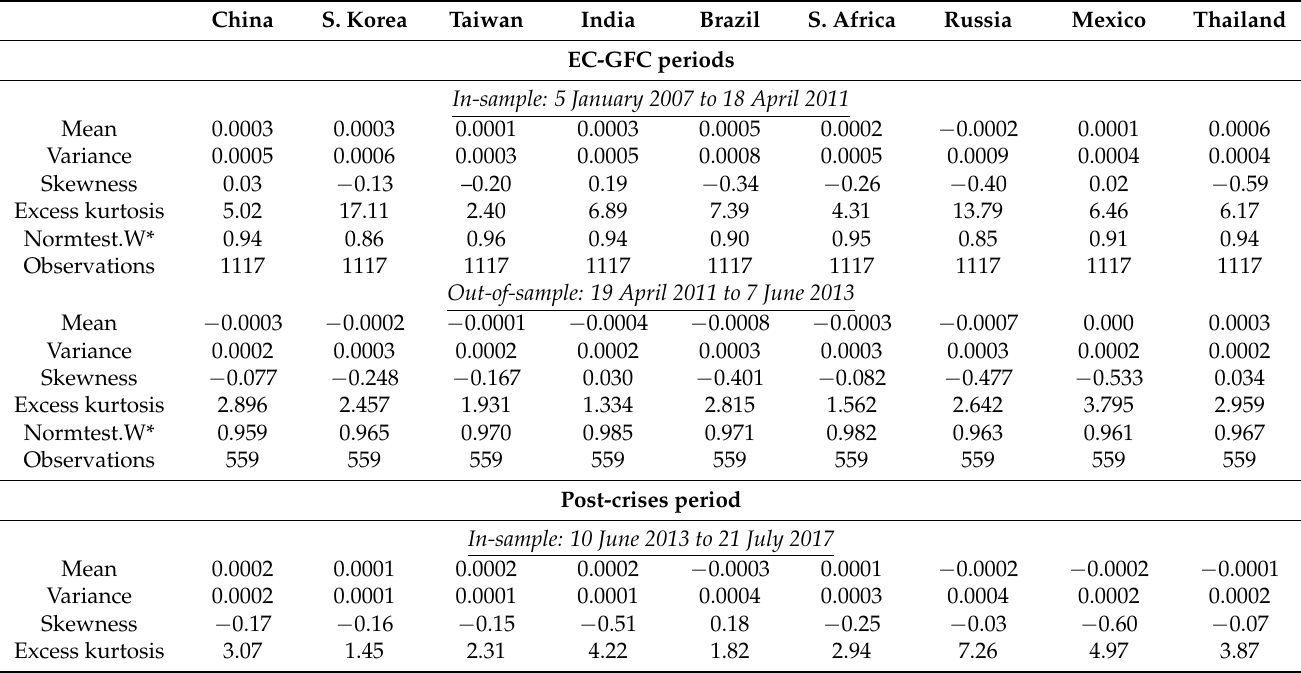
Table 1. Summary statistic of top 9 EMs